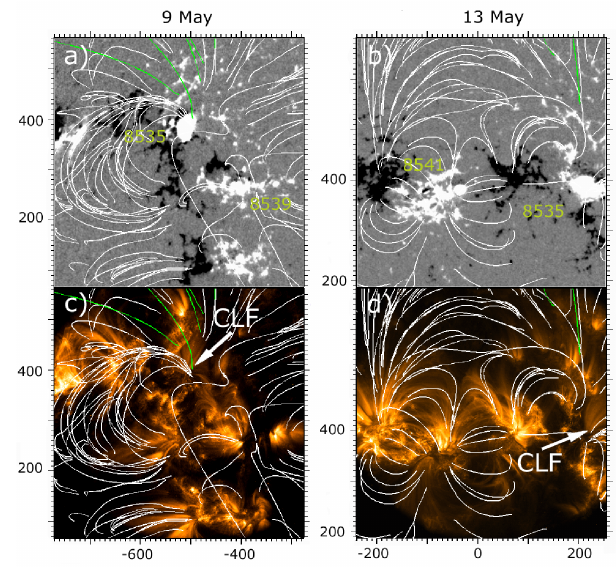
Fig. 6. Magnetic field lines extrapolated with the PFSS model and overlaid on the SOHO MDI magnetograms in panels (a) and (b). The background of panels (c) and (d) are the TRACE 1.71 × 10 − 8 m EUV images. (Courtesy of the Lockheed Martin Solar and Astrophysics